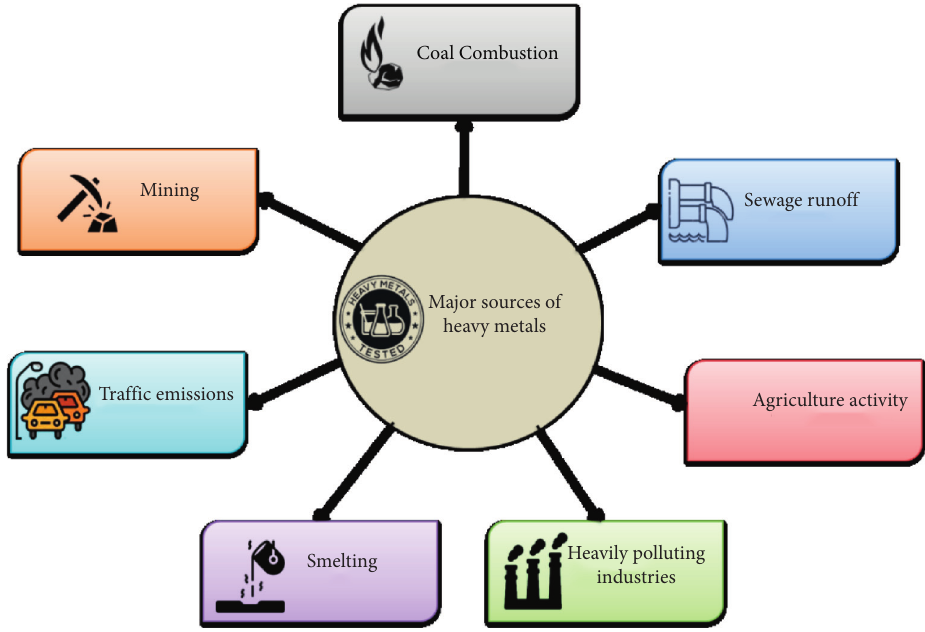
Figure 1: Sources of heavy